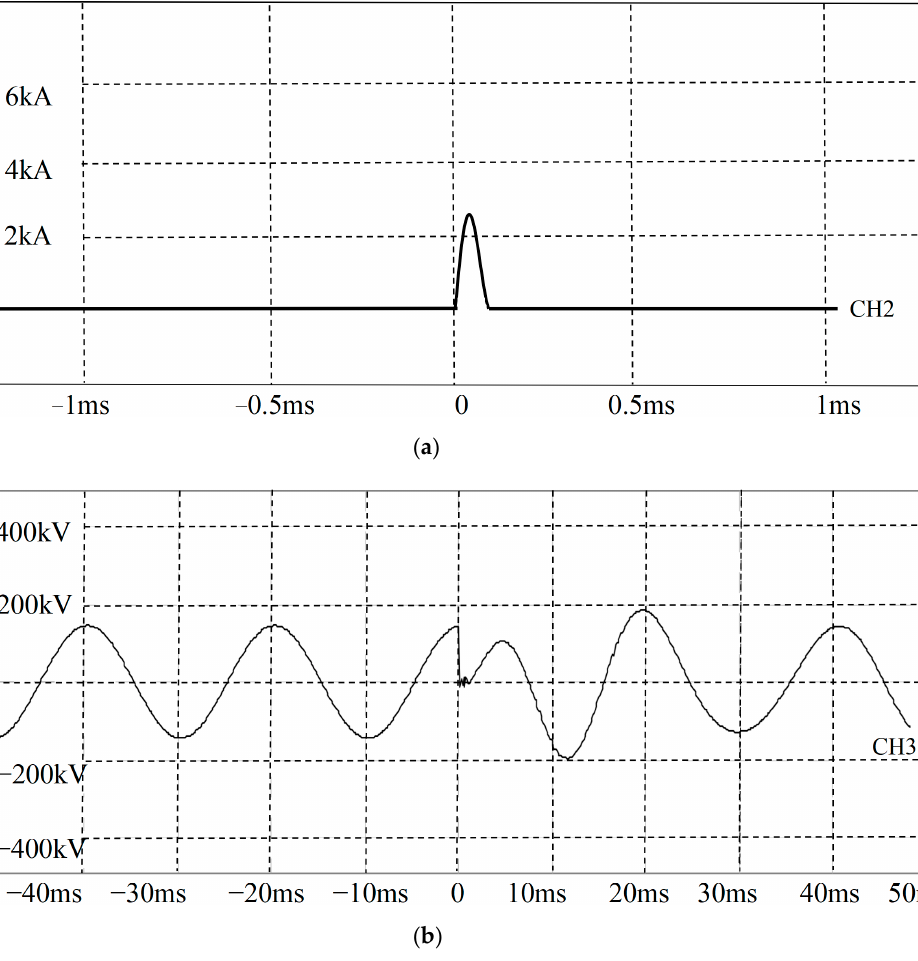
Figure 14. Arc current and voltage waveforms. ( a ) Arc current waveform, ( b ) Arc voltage waveform. Table 5. Comparative table of test data and simulation data.